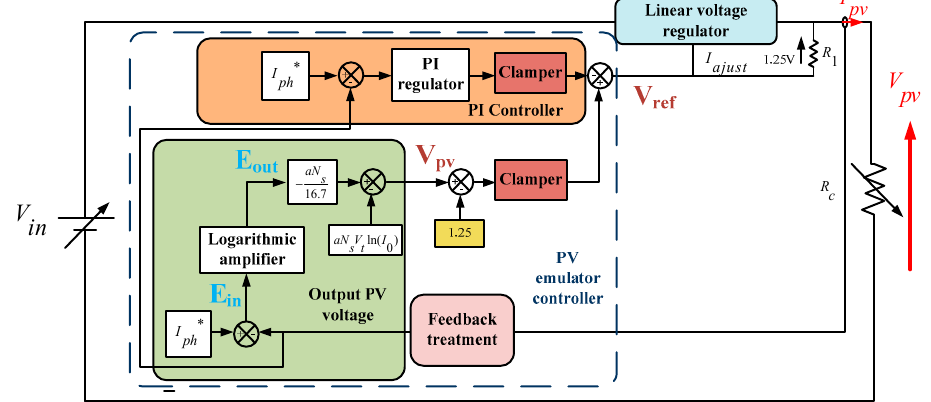
Figure 8. Detailed synoptic diagram of the proposed PV emulator.